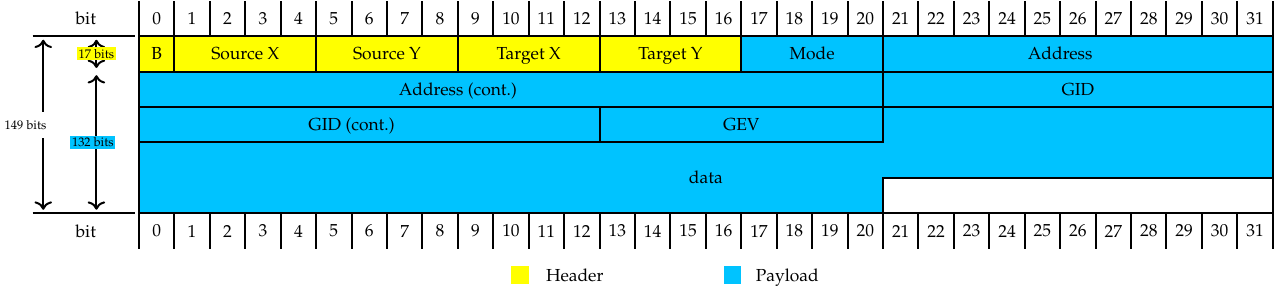
Figure 2. Structure of a network coded flit with 64-bit data field; uncoded flits would have nearly the same structure but without the global encoding vector (GEV) and a flit identifier (FID) instead of the generation identifier